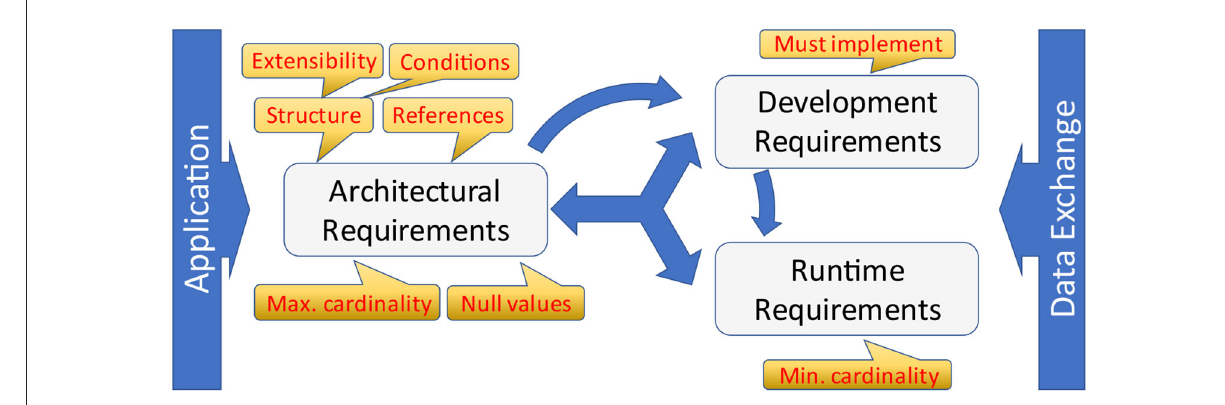
FIGURE9 Architectural, development and runtime requirements.